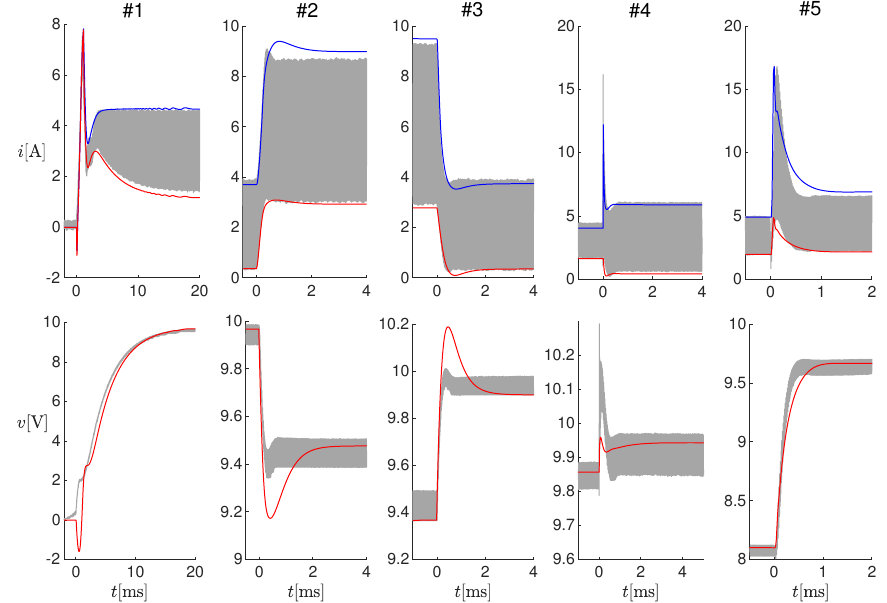
Figure 5. Results of offline estimations on Tests #1-#5 (see Table 3). Top panels: measured current (gray curves) and estimated values ˆ ı k (red curves) and ˆ ı (cid:48) (blue curves). Bottom panel: measured output k voltage (gray curves) and estimated value ˆ v k (red curves).